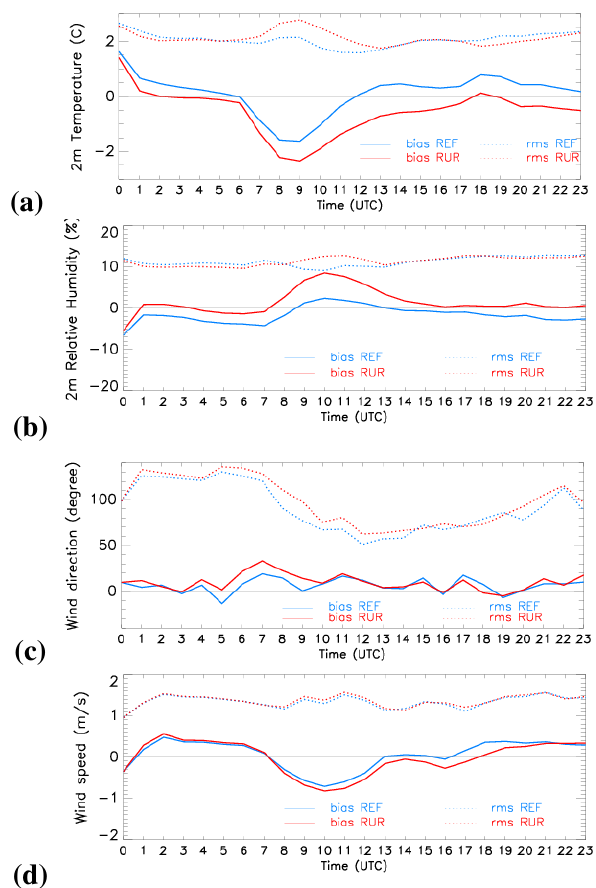
Fig. 9. Daily variation of the bias (solid line) and rmse (dashed line) for the REF (in blue) and RUR simulations (in red) for the 2m temperature (a) , 2m relative humidity (b) , 10m wind direction (c) and 10m wind speed (d) only for the urban